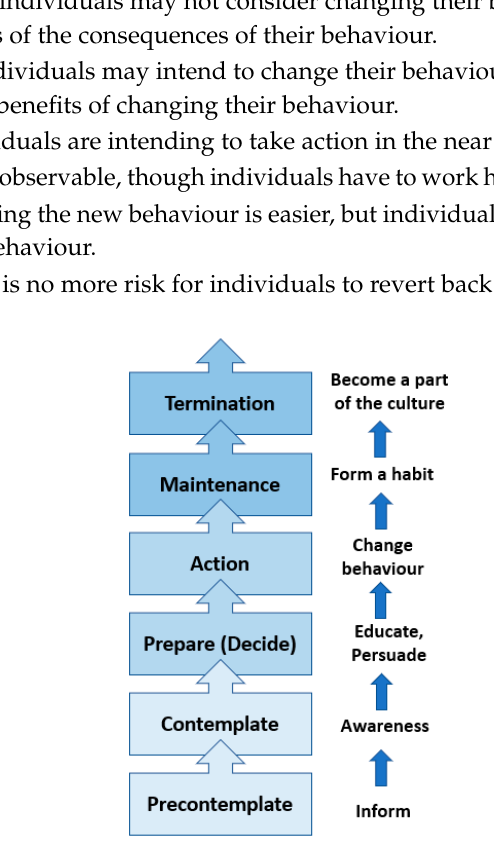
Figure 3. The Transtheoretical Model (TTM) and the behaviour change process.